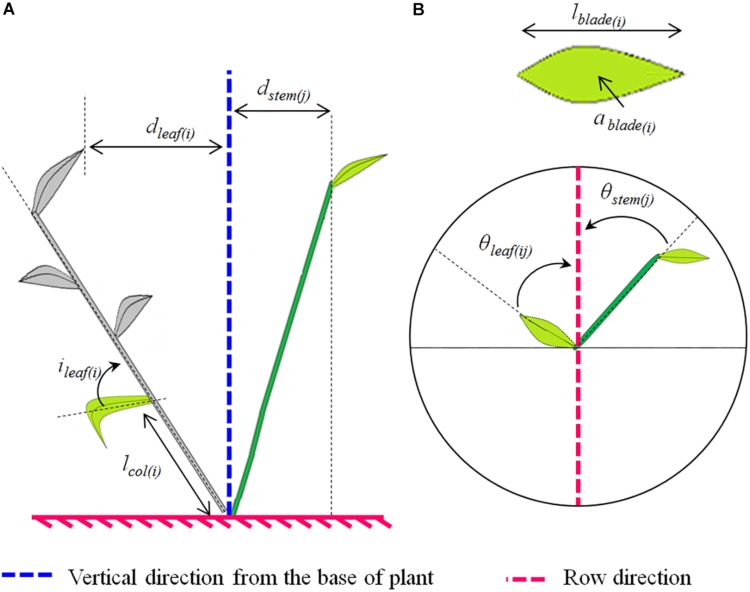
Scheme illustrating the plant architectural traits analyzed (A, side view; B, top view). The analyzed traits depended on the plant axis. For both main stems and tillers we analyzed: (i) the horizontal spread of the axis “j,” which represents the horizontal distance between the higher leaf collar on the axis and the plant base (dstem(j)); (ii) the horizontal spread of the leaf rank at rank “i” on the axis “j,” which represents the horizontal distance between the tip of the leaf and the plant base (dleaf(ij)); (iii) the azimuth angle of the leaf at rank “i” on the axis “j” which represents the angle between the projection of the midrib on the horizontal plane and the row direction (θleaf(ij)); and (iv) the azimuth angle of the stem or pseudo-stem of the axis “j,” which represents the angle between the projection of the stem or pseudo-stem on the horizontal plane and the row direction (θstem(j)). Additionally, the following traits were analyzed for the main stems only: (i) the final blade length of the leaf at rank “i”(lblade(i)); (ii) the mature blade area of the leaf at rank “i” (ablade(i)); (iii) the length between the collar of the leaf at rank “i” and the plant base (lcol(i)); and (vi) the angle of insertion of the leaf at rank “i,” which represents the basal angle between the blade midrib and the bearing axis (ileaf(i)).